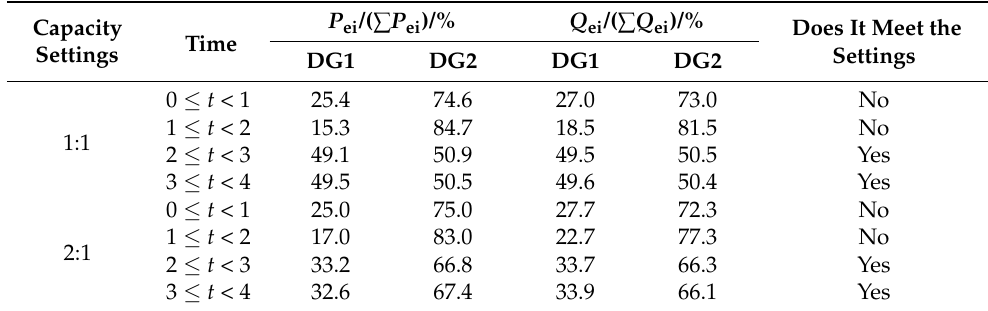
Table 3. DG output power distribution results .